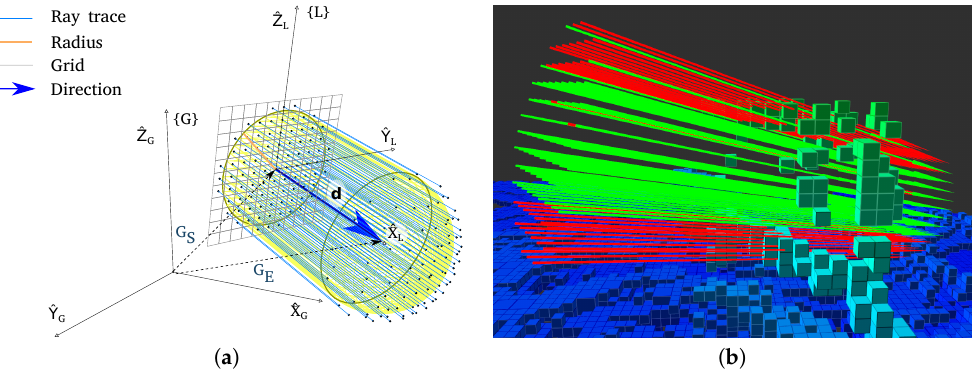
Figure 1. Ray traces used in the geometrical approach. The cylindrical shape with the hemisphere around the goal can be identified in both images. ( a ) Visualization of the flight corridor with the grid illustrating the space discretization resolution. ( b ) Simulation example in which red rays have collided with obstacles but green rays are in free